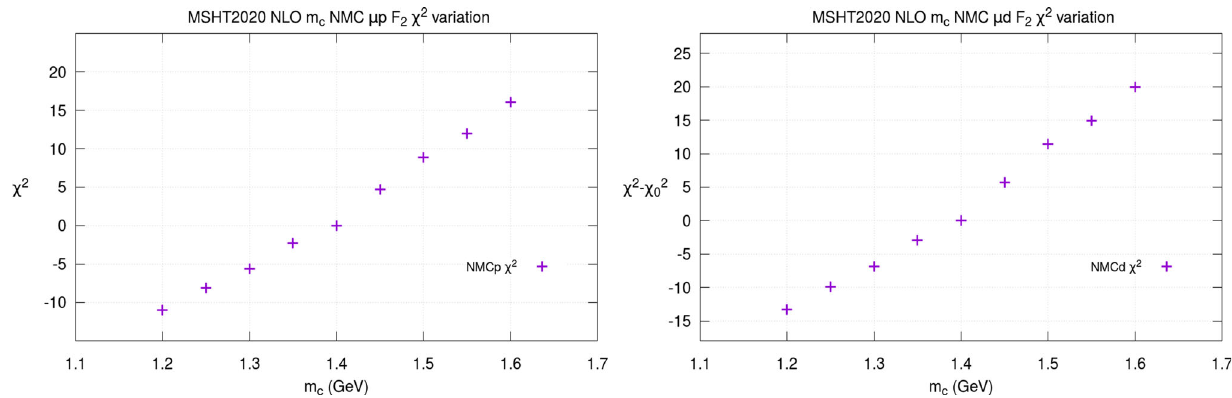
) = 0 . 118 for (left) the NMC F p